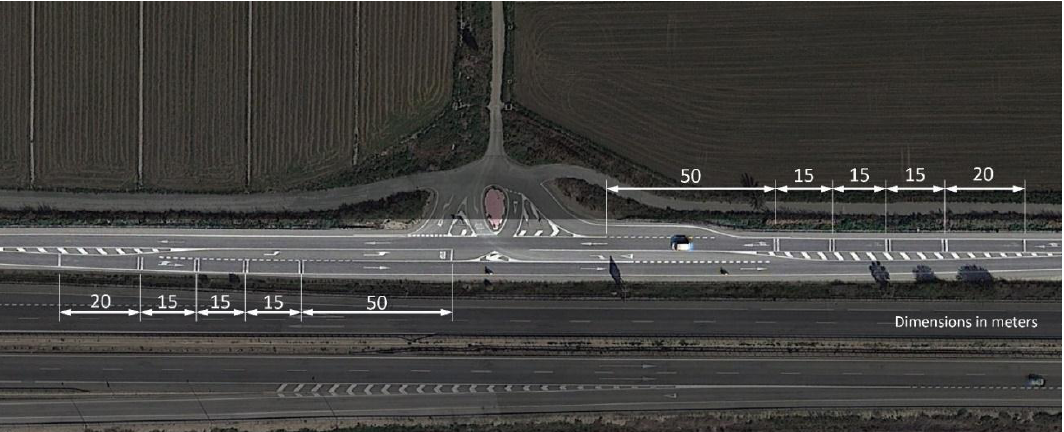
Figure 2. Test section general layout.